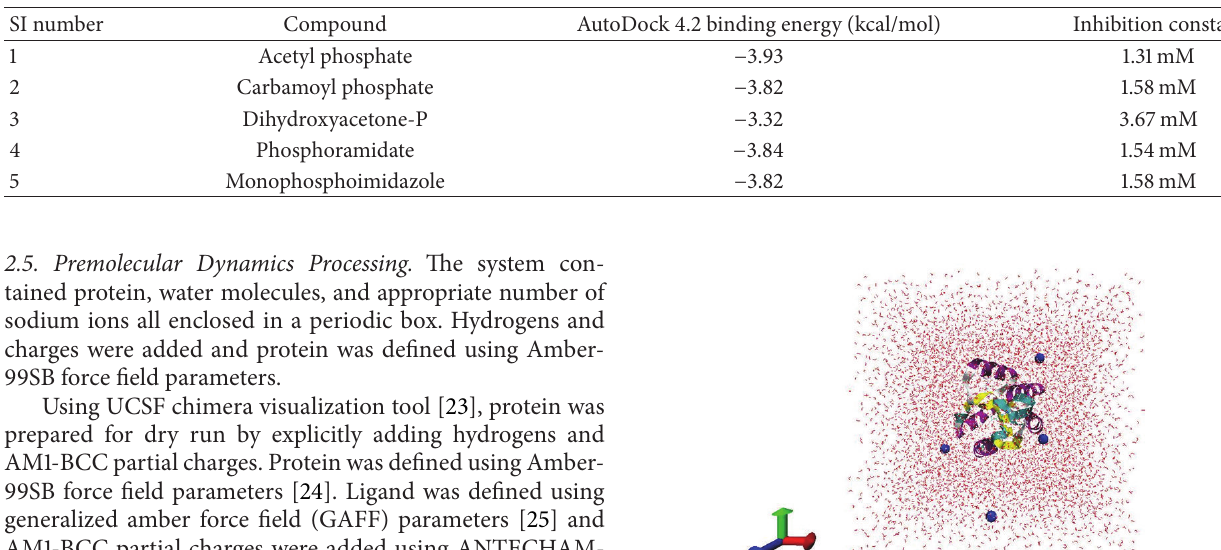
Figure 1: Active site residues of NarL are represented in ball and stick. Table 1: Energy profile of small molecule phospho-donors.